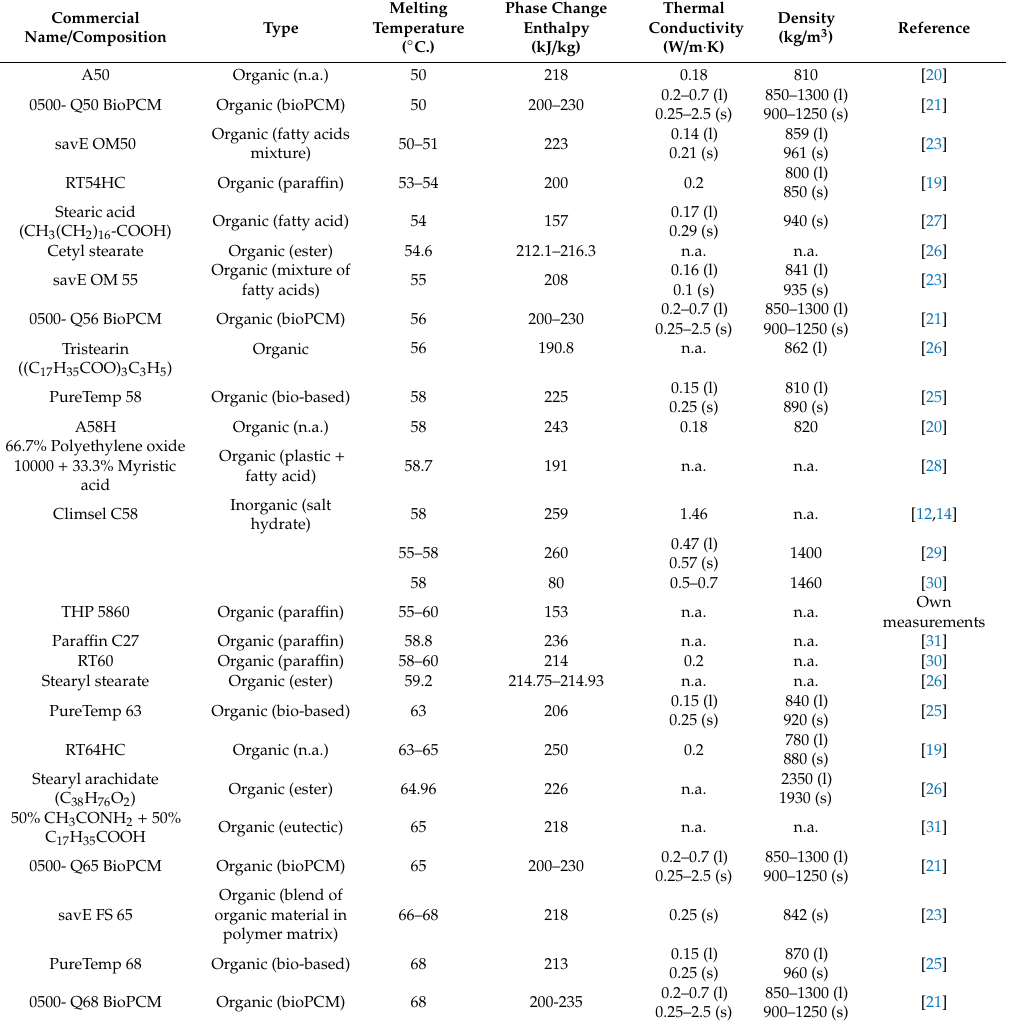
Table 4. Pre-selected PCM for the Continental system and some of their thermophysical properties as reported in the